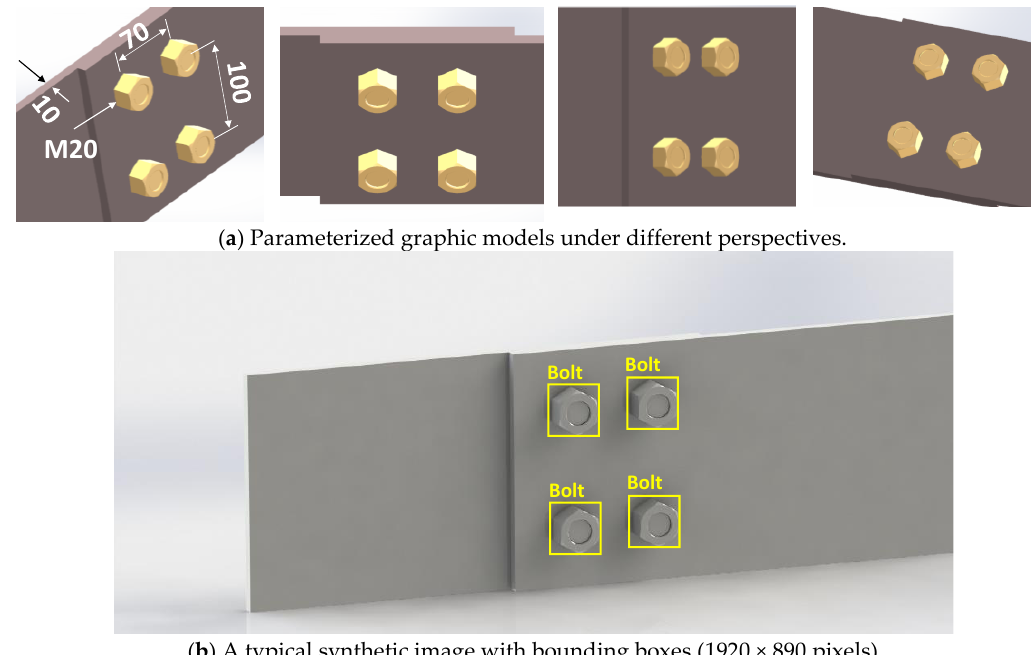
Figure 5. Synthetic data for training the deep learning-based bolt detection model.